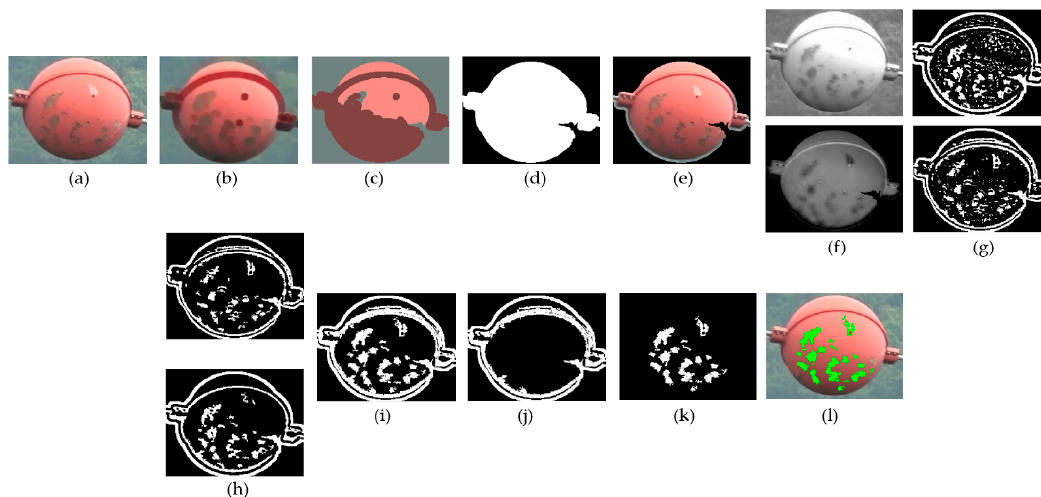
Figure 7. Steps to detect defect in balisor. ( a ) Input image after detection using CNN, ( b ) after eroding, ( c ) color clustering, ( d ) foreground mask after clusters selection and region filling, ( e ) masked foreground, ( f ) balisor image in R- and S-color space, ( g ) after filtering ( f ), ( h ) after removing noise from ( g ), ( i ) combination of R- and S-space outputs in ( h ), ( j ) mask for boundary regions, ( k ) removing boundary regions, and ( l ) marking the defected regions.